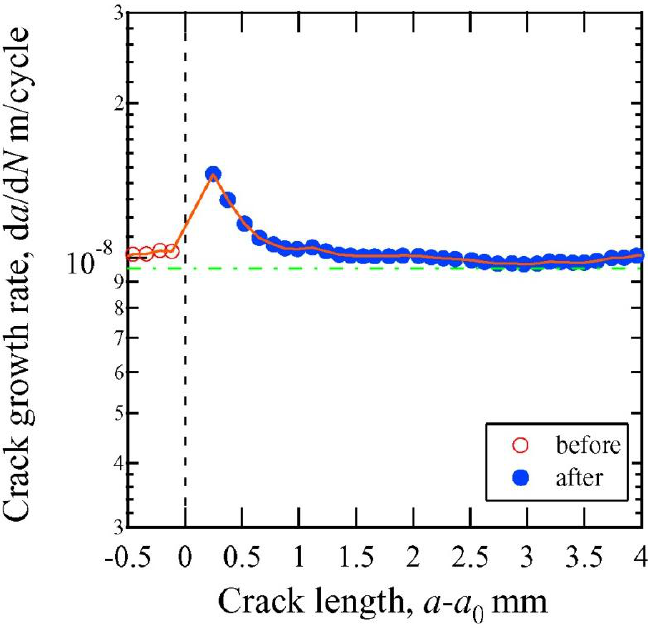
Figure 9. Fatigue crack growth rate as a function of crack length before the application and after the 25th application of electropulsing for Sample B.